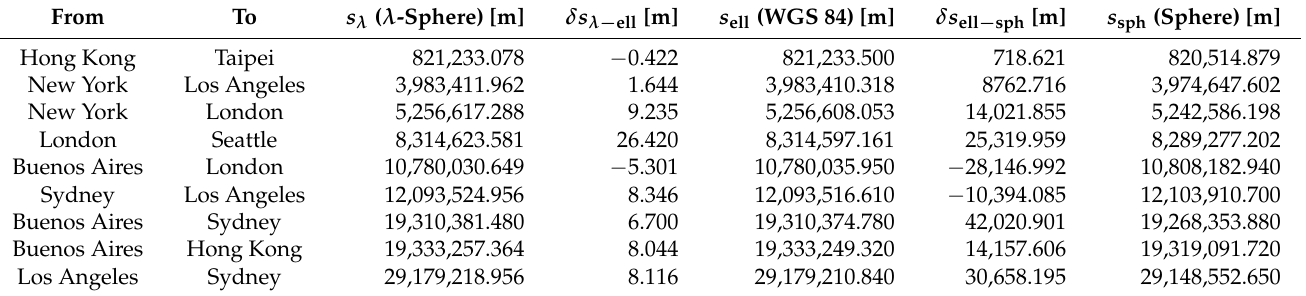
Table 3. Comparison of values for arc lengths calculated from the inverse problems for loxodromes based on the λ -sphere’s, WGS 84 ellipsoidal, and spherical reference models for the geoid. From